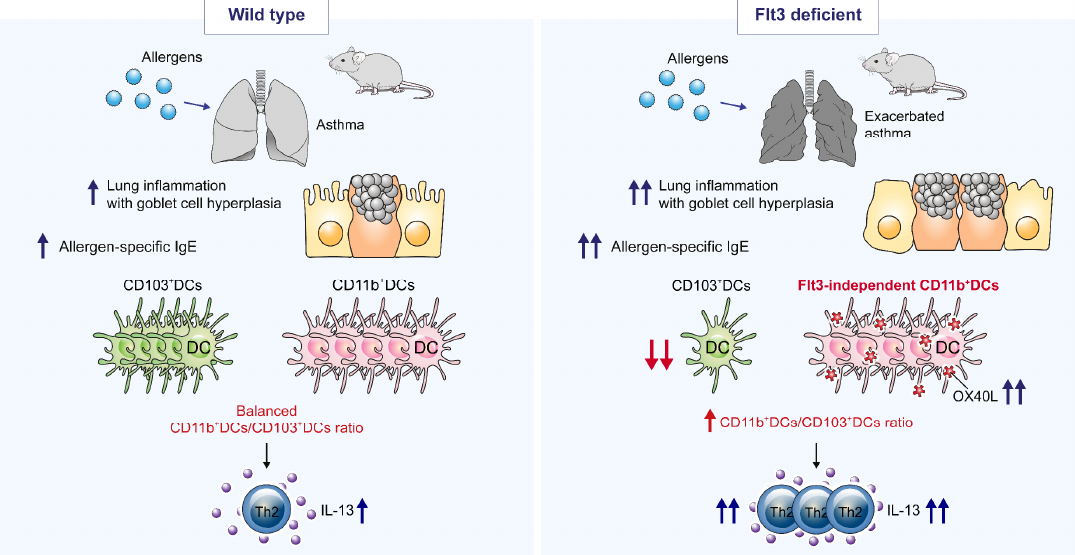
Figure 8. Schematic of changes in allergic asthma and the population of dendritic cells (DCs) associated Figure 8 with Flt3 (Fms-like tyrosine kinase 3) deficiency. Allergic asthma was su ffi ciently induced in Flt3 knockout (KO) mice, even though DCs, and particularly CD103 + DCs, were deficient. Upon allergen challenge, lung inflammation with goblet cell hyperplasia, serum allergen-specific IgE levels, and IL-13 in the lung were increased in Flt3 KO mice, compared to the case in WT mice. These findings were associated with OX40 ligand (OX40L) expression, which was inhibited by the Flt3 ligand. Thus, Flt3-independent CD11b + DCs are the principal cause of exacerbated Th2 immune responses; the ratio of CD11b + DCs to CD103 + DCs is important for allergic